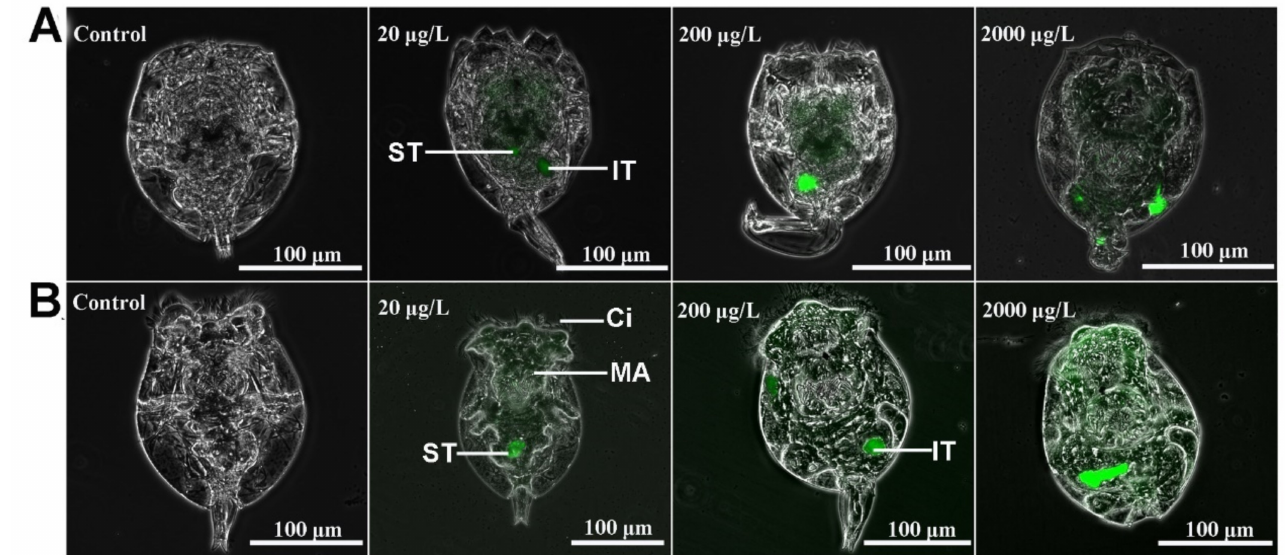
Figure 1. Fluorescently labeled MPs with sizes of 0.1 µ m ( A ) and 1 µ m ( B ) were observed in rotifers. Ci, cilia; IT, intestine; MA, mastax; ST,